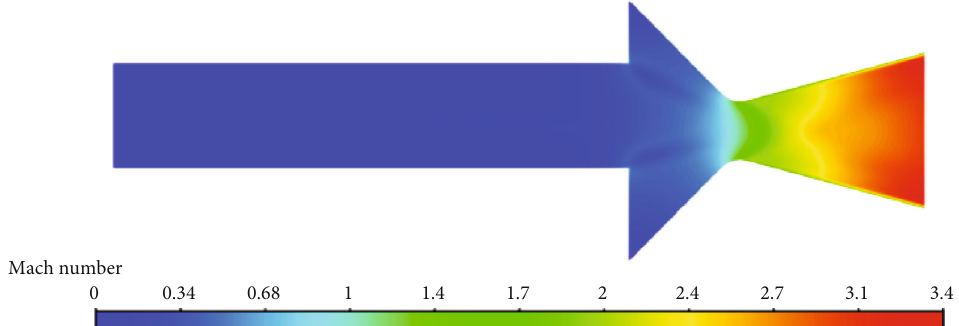
Figure 16: Contour of Mach number distribution.